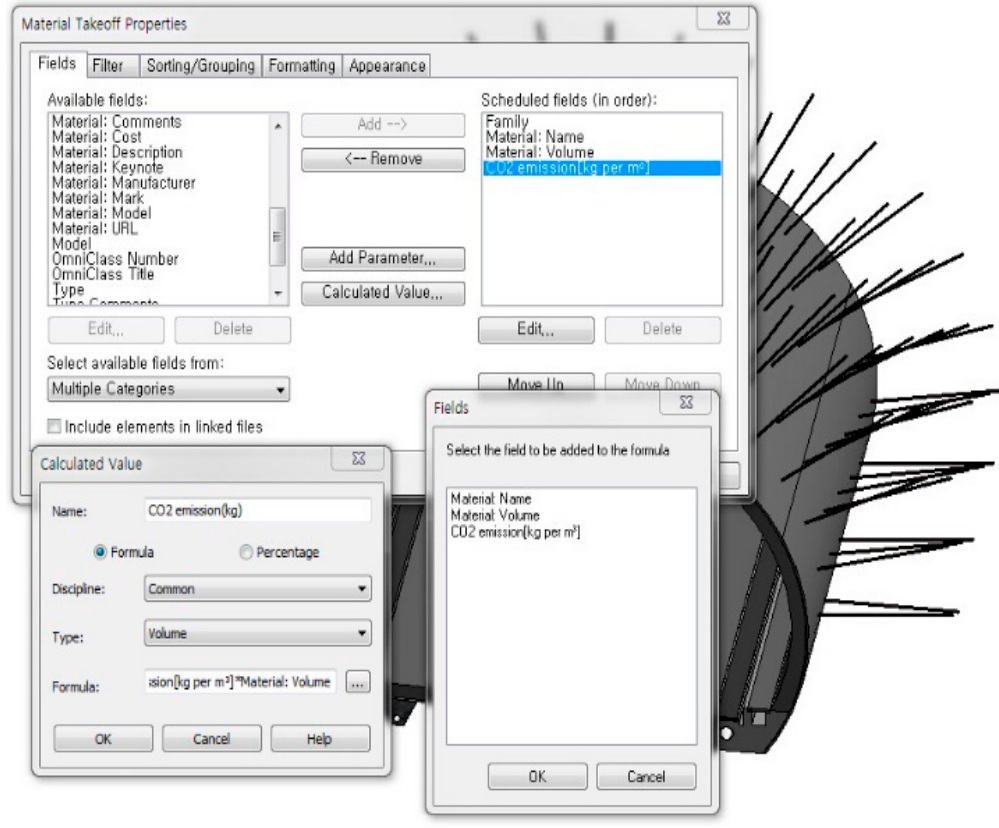
Figure 6. Making a CO 2 emission computing formula.